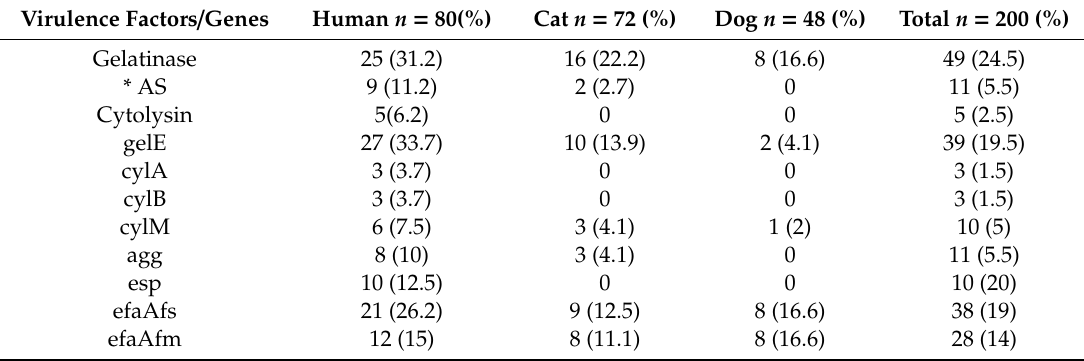
Table 5. Distribution of virulence factors and genes among E. faecalis and E. faecium isolates: cytolysin (cylA, cylB, cylM), aggregation substance (agg), gelatinase (gelE), enterococcal surface protein (esp), and cell wall adhesins (efaAfs and